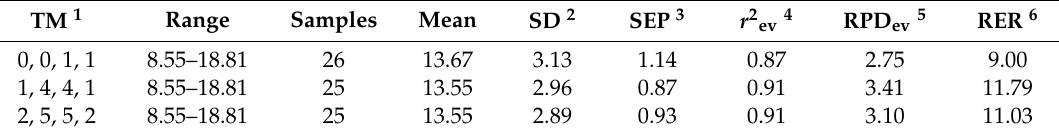
Table 4. Statistics of the external validation ( n = 26) applied to the calibration equations of the fibre content in Brassica